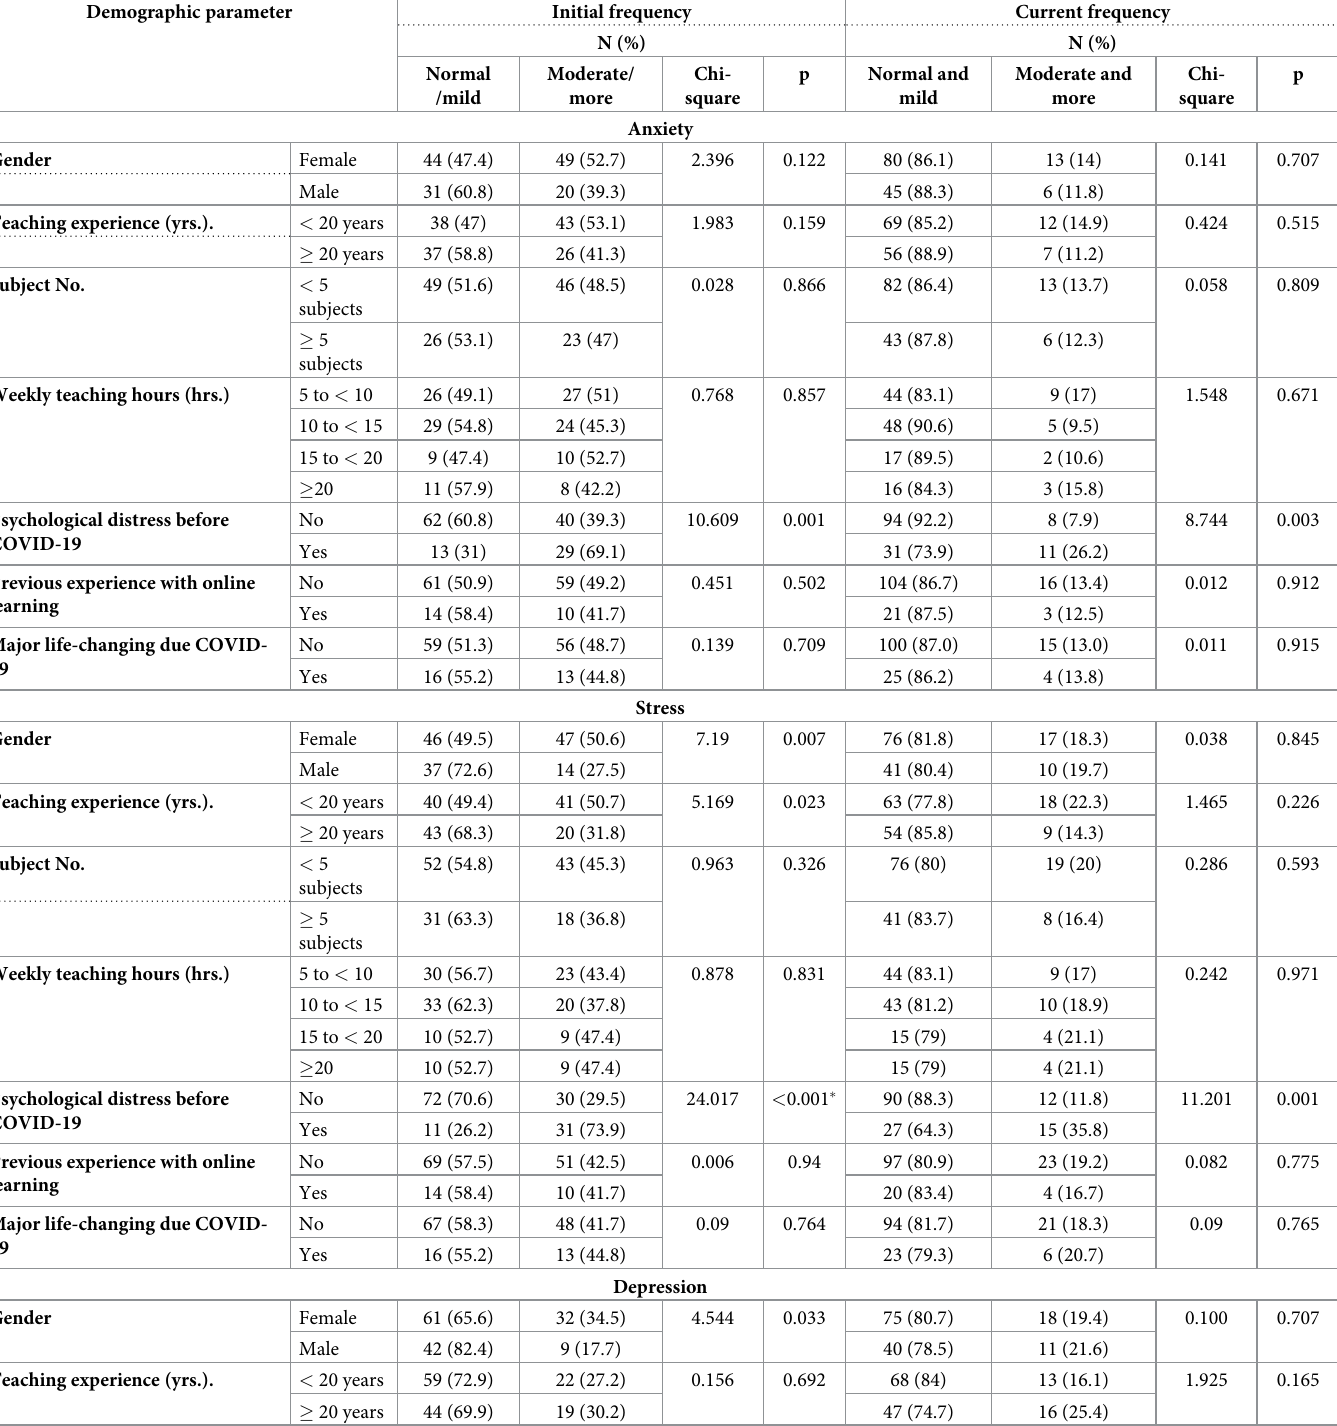
Table 3. Inter-frequencies analysis between initial and current levels of anxiety, stress, and depression using Chi-square test of independence with Bonferroni correction. Demographic